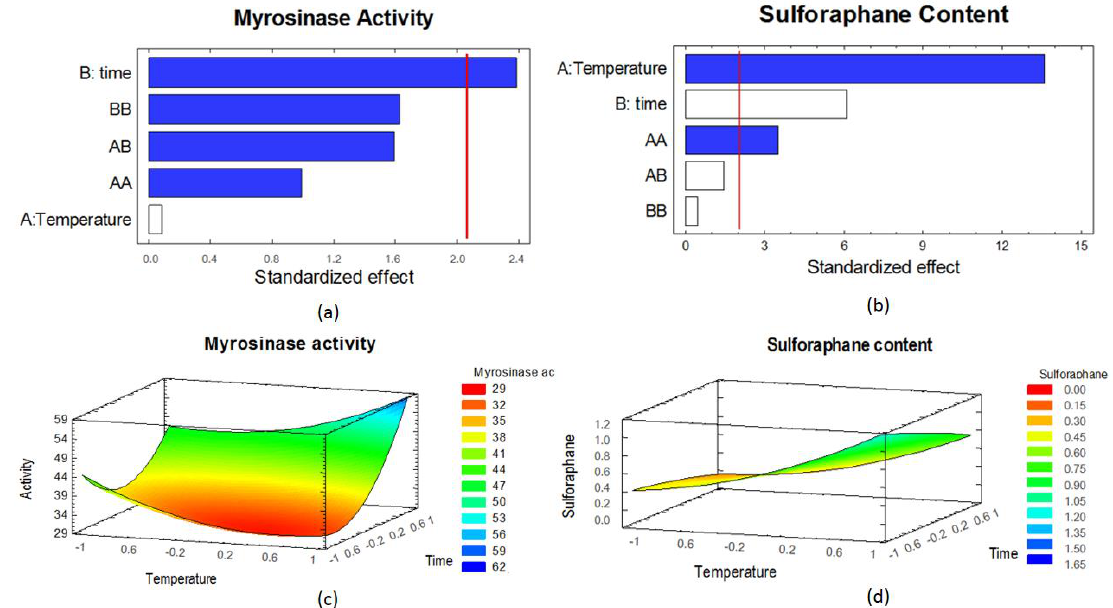
Figure 2. Standardized statistical effects and response surface of the experimental factors on myrosinase activity and sulforaphane content. ( a ) Pareto chart for myrosinase activity; ( b ) Pareto chart for SFN content; ( c ) response surface for myrosinase activity; ( d ) response surface for SFN content. Blue bars indicate positive effect; white bars indicate negative effect. A: blanching temperature; B: blanching time; any combination of A and B: combined effect of the experimental factors.